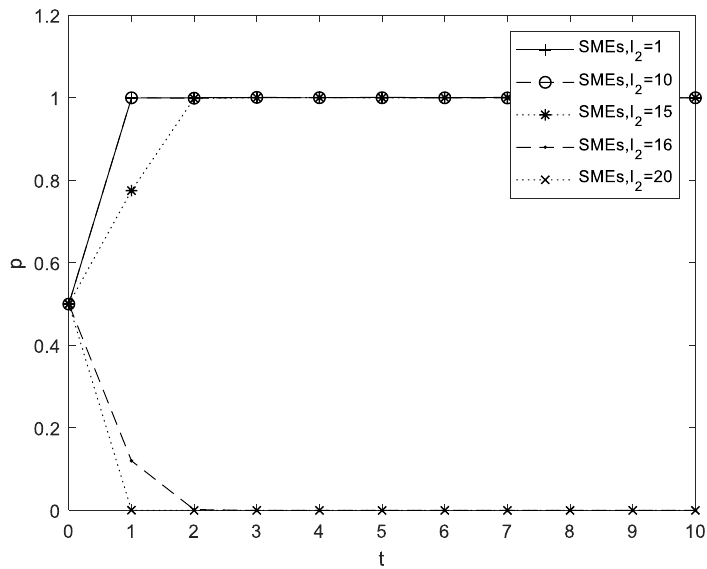
Figure 14. Effects of inventory 𝐼 2 on the system evolution